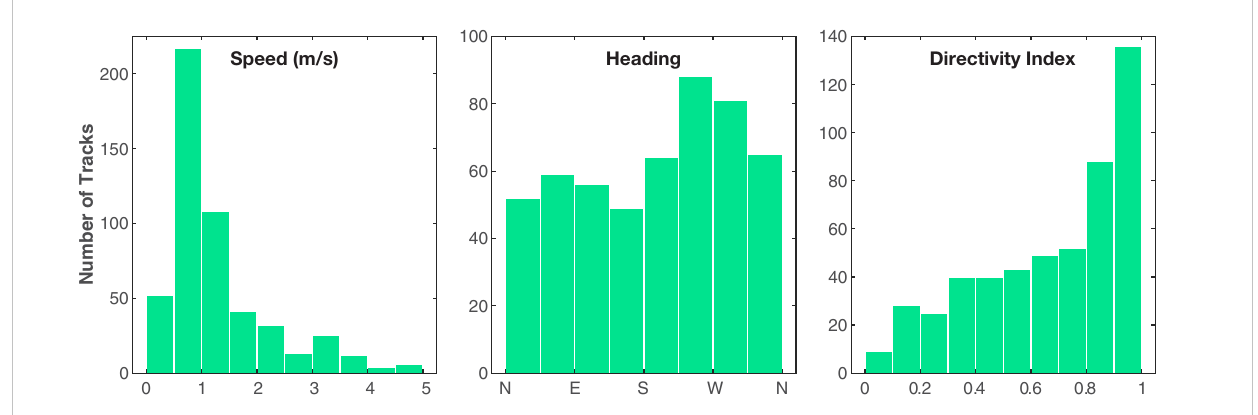
FIGURE 3 Histograms of the average speed (m/s), average heading, and directivity index (straight-line distance traveled divided by the total distance traveled) for each minke whale